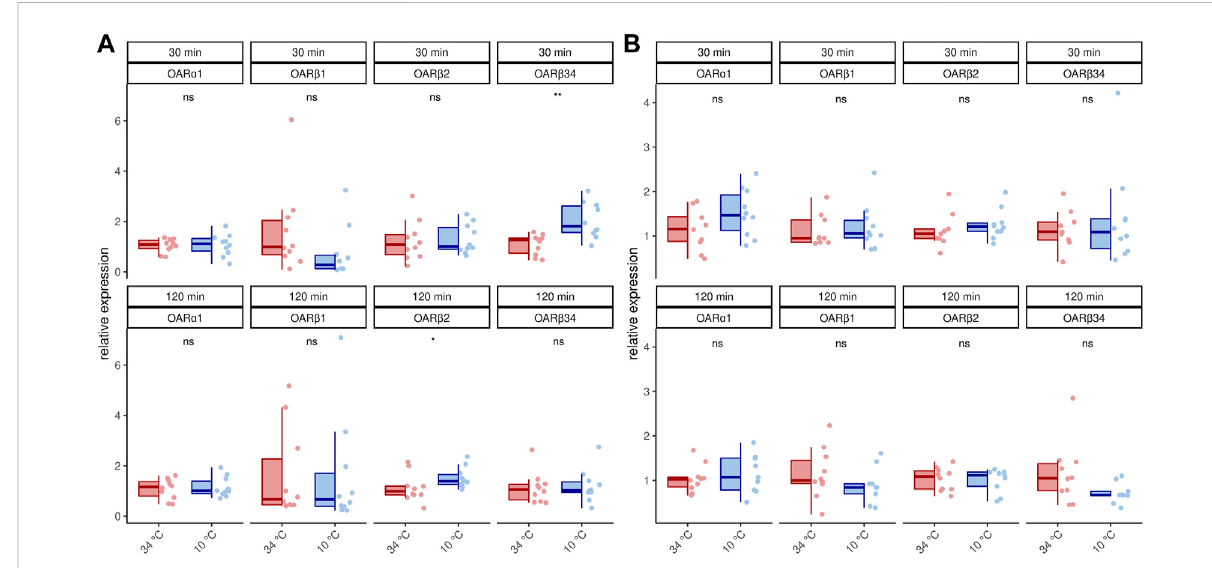
FIGURE 2 Octopamine receptor gene expression in the fl ight muscles workerbees under cold stress. One week old workerbees (A) and forager bees (B) were cold stressed for 30 and 120 min and subsequently, the relative octopamine receptor gene expression was quanti fi ed in fl ight muscles (DV + DL).*= p < 0.05,**= p < 0.01,ns= p ≥ 0.05,Mann-Whitney U test.Fordetailed statisticspleaseseeTable2.Foreachgroup/data-setmedian±IQR (left part) and individual data points (right part) are